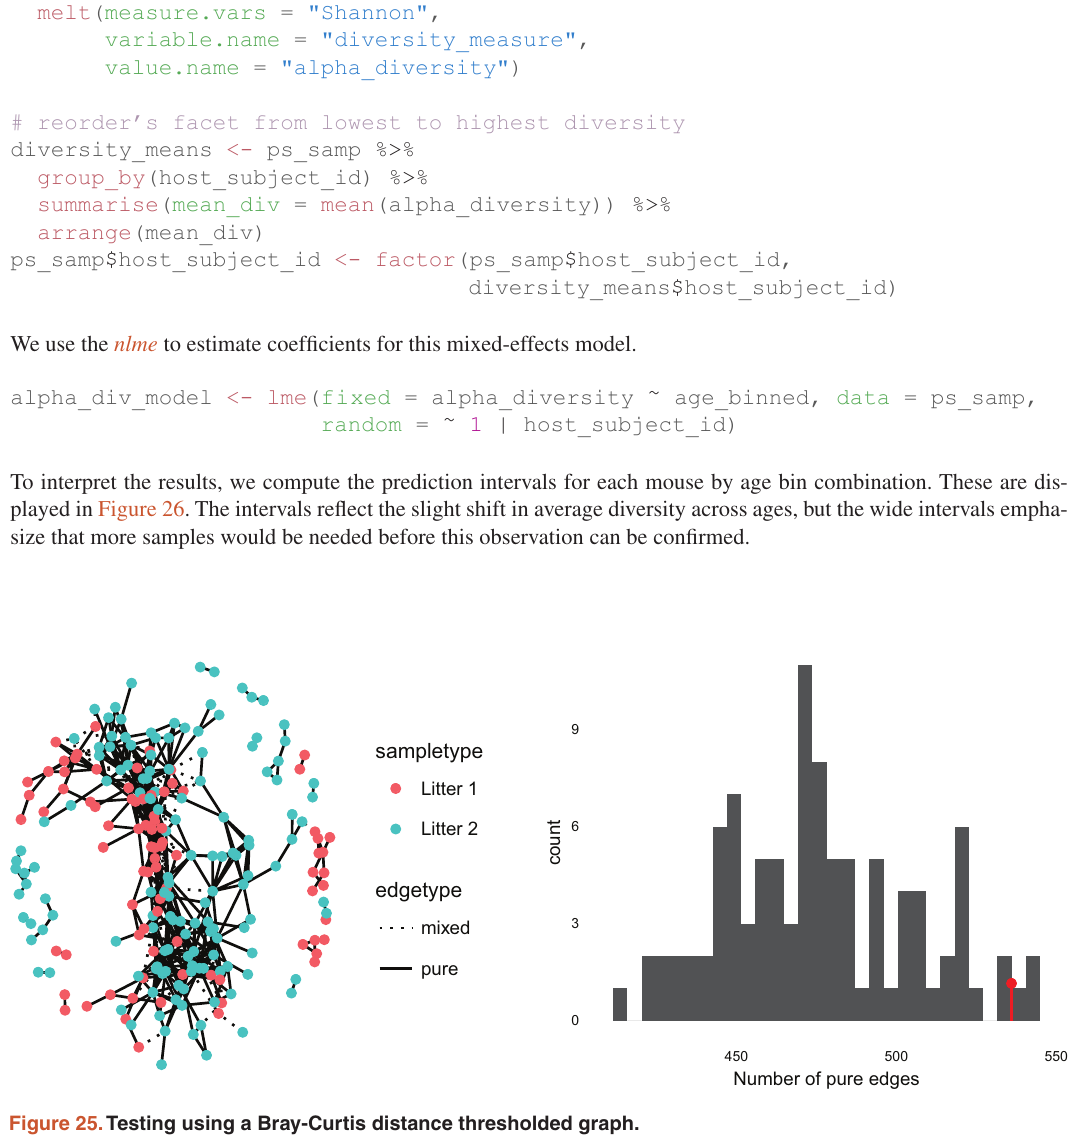
Figure 25. Testing using a Bray-Curtis distance thresholded